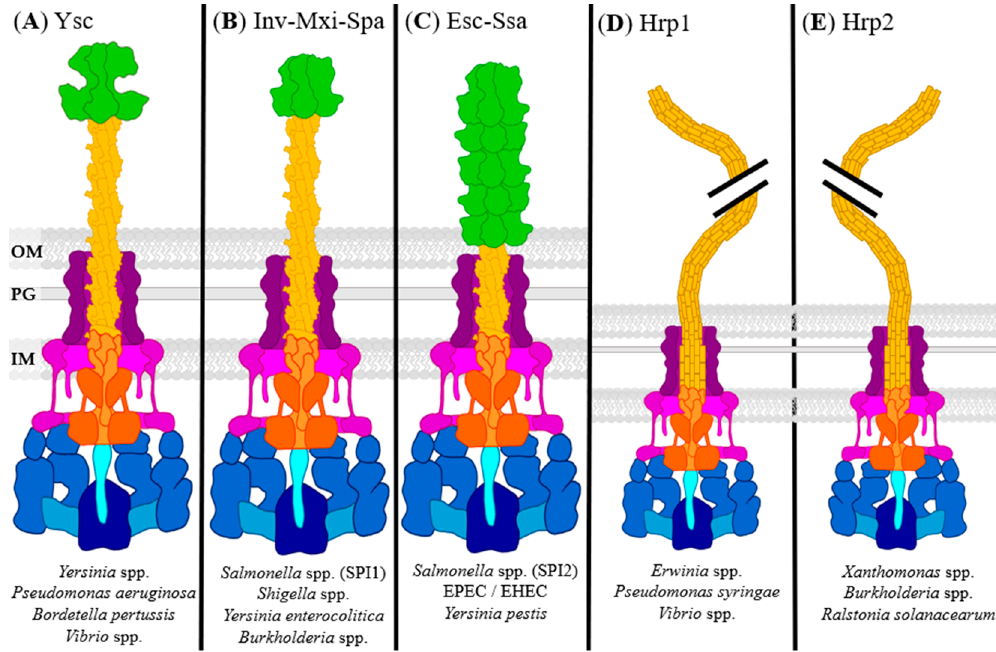
Figure 2. The 5 main groups of T3SS needles. ( A ) Ysc Group; ( B ) Inv-Mxi-Spa Group; ( C ) Esc-Ssa Group; ( D ) Hrp1 Group; ( E ) Hrp2 Group. Modified from [59]. Abbreviations: SPI1, Salmonella pathogenicity island; SPI2, Salmonella pathogenicity island 2; OM, bacterial outer membrane; PG, bacterial peptidoglycan layer; IM, bacterial inner membrane.